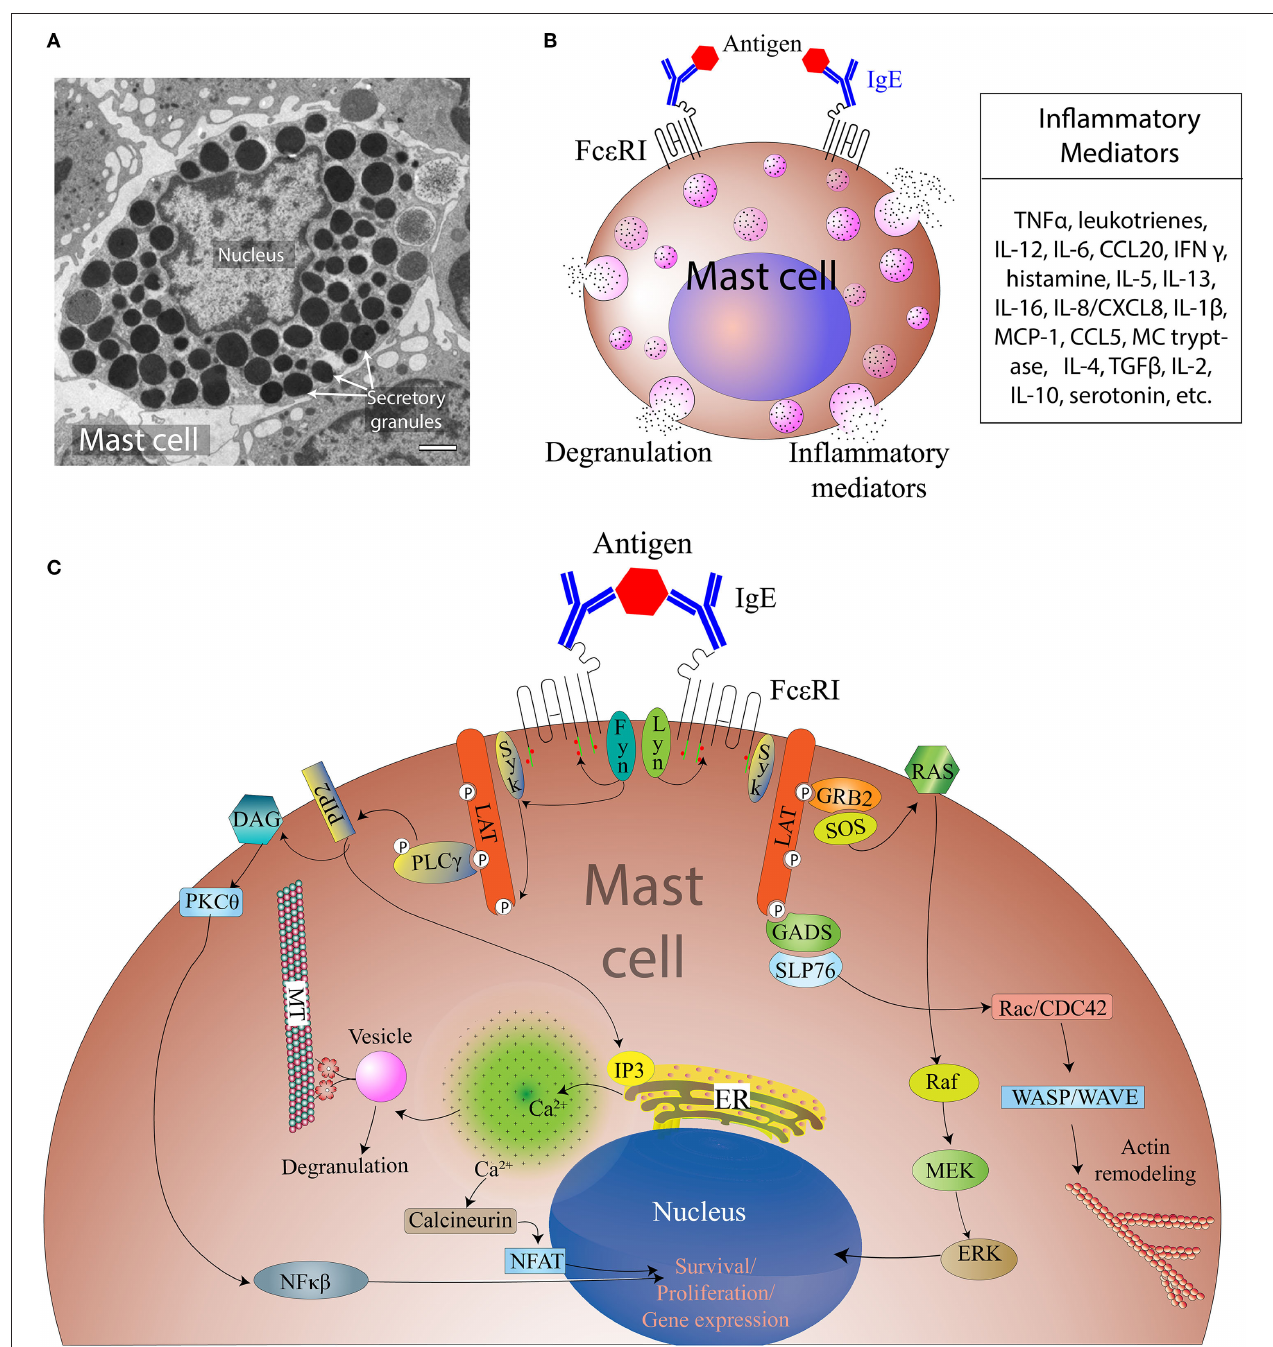
FIGURE 1 | Overview of MC activation and degranulation mechanisms. (A) A transmission electron microscope image of an activated MC showing multiple secretory granules inside the cell. Adapted from Grujic et al. (25) and reproduced with written permission from the publisher. Copyright 2013, the American Association of Immunologists, Inc. (B) A schematic of a MC showing Immunoglobulin E (IgE)-mediated interaction with allergen and secretion of different inflammatory mediators. (C) . Aggregation of the IgE Receptor (Fc ε RI) by multivalent antigen induces activation of tyrosine-protein kinase Lyn (Lyn), the Src kinase that phosphorylates immunoreceptor tyrosine-based activation motifs (ITAMs) of Fc ε RI β and γ subunits, followed by the association of the tyrosine-protein kinase Syk with the Fc ε RI via Syk-Src Homology domain 2 (SH2) within phosphorylated ITAMs. This clustering leads to activation of tyrosine-protein kinase Fyn that phosphorylates the adaptor growth factor receptor-bound protein 2 (Grb2). Activation of phospholipase C gamma 1 (PLC- γ 1) results in the hydrolysis of phosphatidylinositol-4,5-bisphosphate (PIP2) into inositol 1, 4, 5-triphosphate (IP3) and diacylglycerol (DAG). IP3 production leads to increased intracellular free calcium (Ca 2 + ) concentration, whereas DAG can activate both protein kinase C- θ (PKC- θ ) and Ras. Tyrosine phosphorylated SLP76 also associates with the Rho-family guanine nucleotide exchange factor (GEF) Vav1 and the adaptor protein, Nck. Vav1 activates Rac and cell division control protein 42 (Cdc42), which initiate actin cytoskeletal rearrangement via activation of Wiskott-Aldrich syndrome protein (WASP). Cytoskeletal rearrangement is required for cell migration and microtubule-dependent degranulation of MCs.